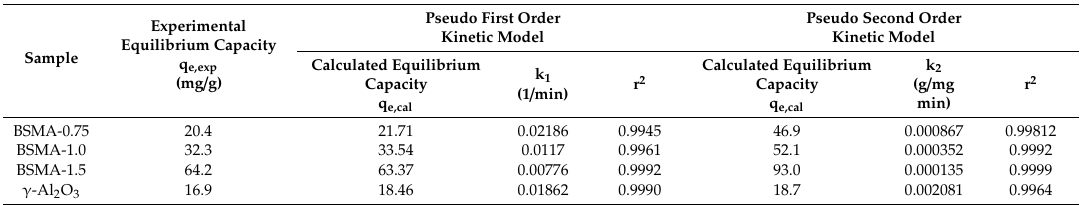
Table 1. Pseudo-first-order and pseudo-second-order kinetic model parameters of commercial gamma alumina and the synthesized BSMA adsorbents on ammonia